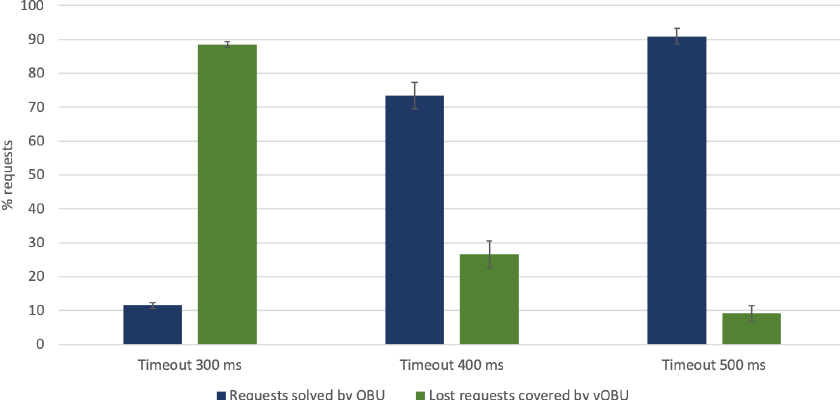
Figure 9. Requests solved by OBU and vOBU as the response timeout varies.